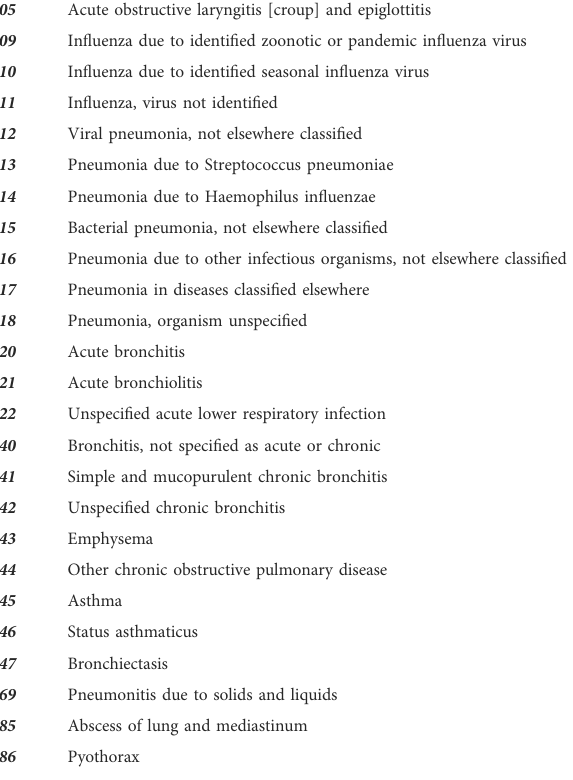
TABLE 1 List of ICD-10 Codes included in the